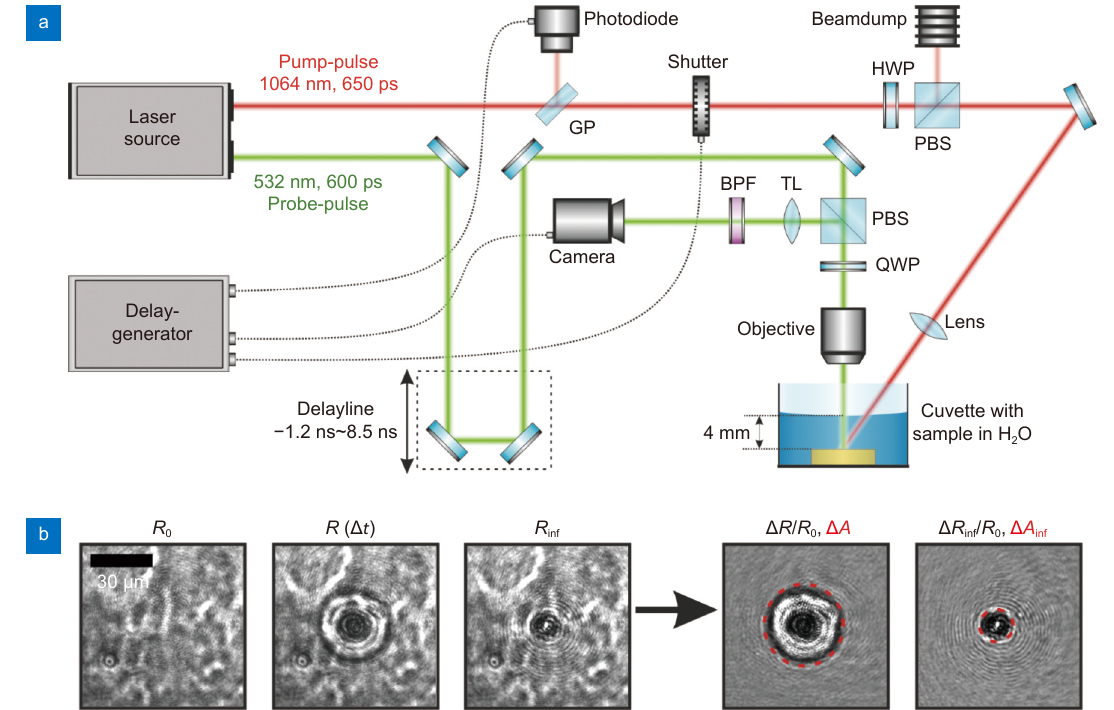
Fig. 1 | ( a ) Pump-probe microscopy setup for the ablation in water. For the analysis of the ablation process in air, no cuvette is used, otherwise the setup is the same. ( b ) Image post processing of the three recorded images. The images of the pristine surface ( R 0 ), during the ablation pro- cess ( R (Δ t )) and after the ablation process has finished ( R inf ) were used to calculate the transient (Δ R/R 0 ) and final state (Δ R inf / R 0 ) relative re- flectivity change. The red dashed circles mark the transient laser-modified area Δ A and the final laser-modified area Δ A inf